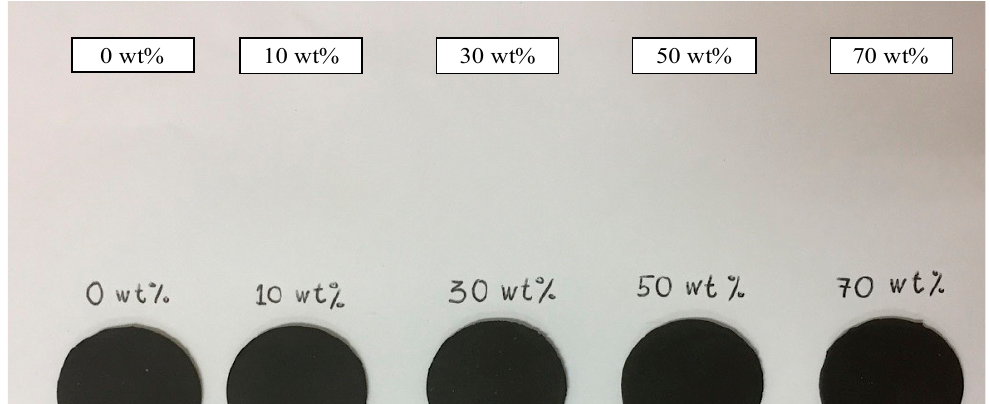
Figure 8. The cylindrical film of ENR-based MRE samples prepared for rheological measurement.